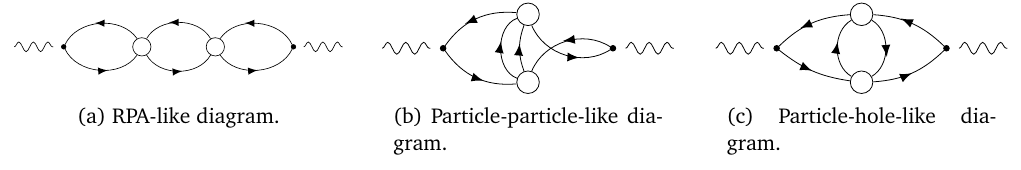
Figure 2: Second order Hugenholtz diagrams for the polarization without self- energy